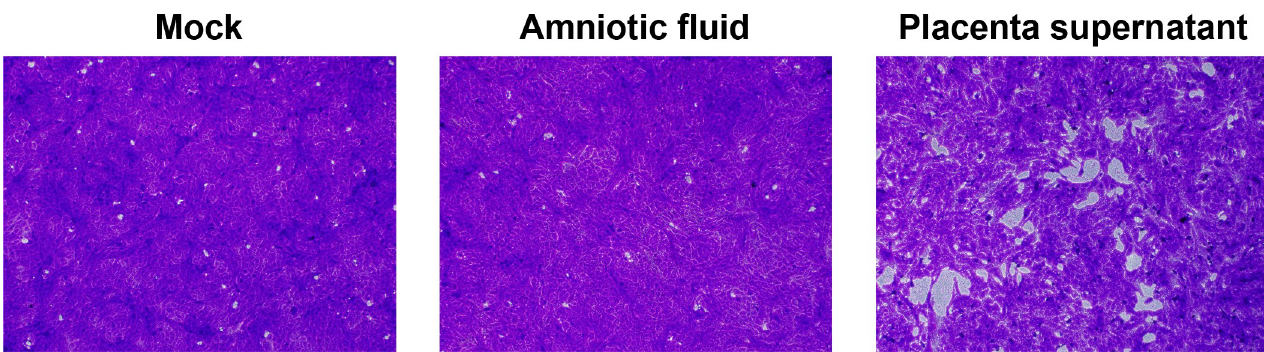
Fig 1. ZIKV plaque formation Vero cells. Amniotic fluid and placental supernatant were collected by C-section from animal #5574 at 26 days post infection (dpi) following detection of intrauterine fetal demise. Amniotic fluid added to Vero cell monolayers produced no observable lesions, whereas placental supernatant produced plaques. Monolayers were stained with crystal violet, and images were taken with a 10x objective.